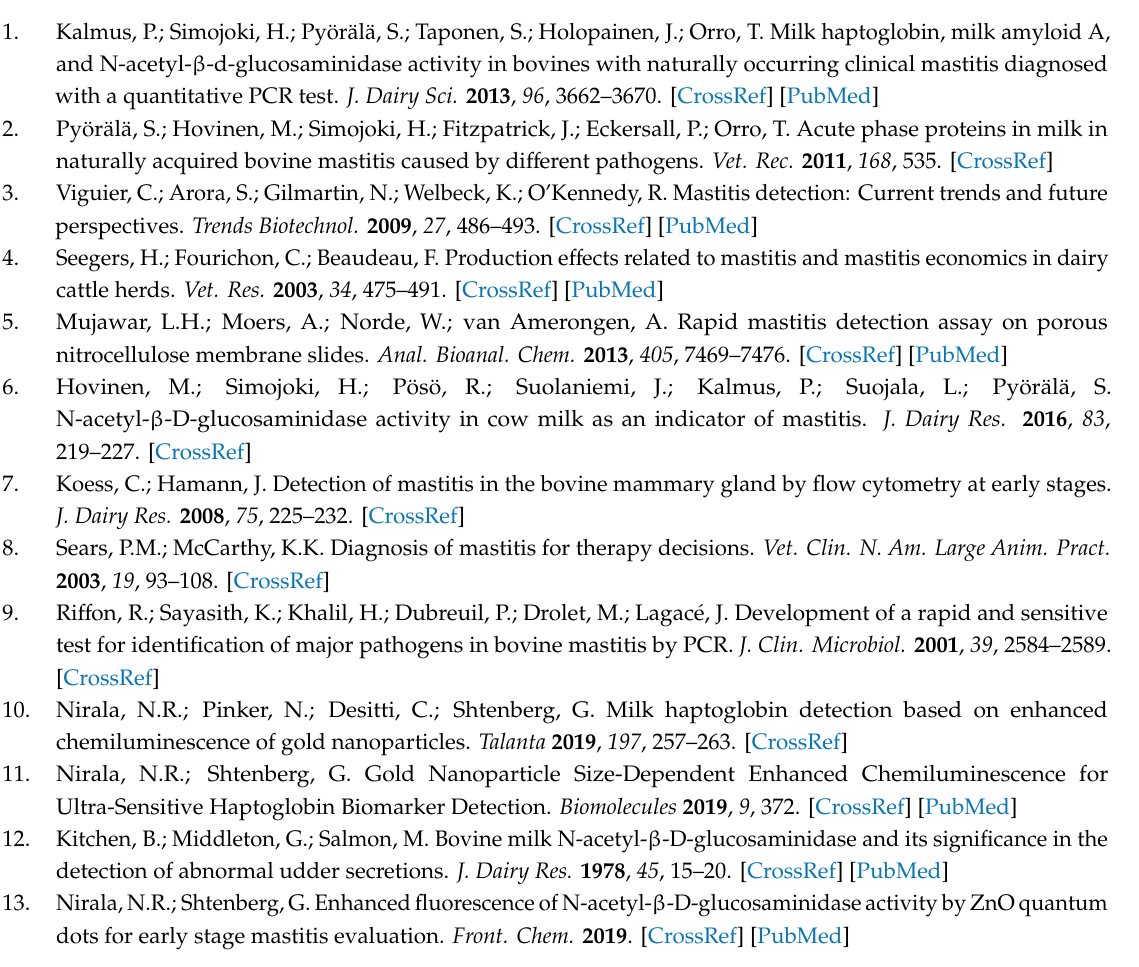
Figure S1: EDX elemental analysis of ZnO-QDs and ZnO-QDs-SiO 2 , Figure S2: EDX elemental analysis of ZnO-NPs and ZnO-NPs-SiO 2 , Figure S3: Emission spectra of di ff erent TEOS amounts added to coat ZnO-NPs, Figure S4: Calibration curves of NAGase enzymatic activity product with and without ZnO nanomaterials. Table S1: NAGase enzymatic activity product recovery studies within control milk samples with and without ZnO